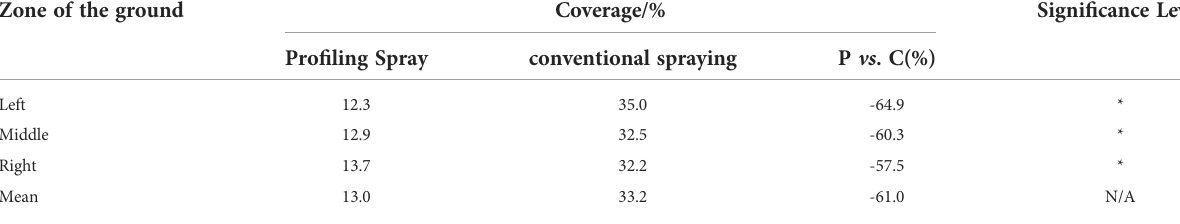
TABLE 6 Droplet coverage on ground water sensitive paper (3 positions) in pro fi le variable spraying and conventional spraying. Zone of the